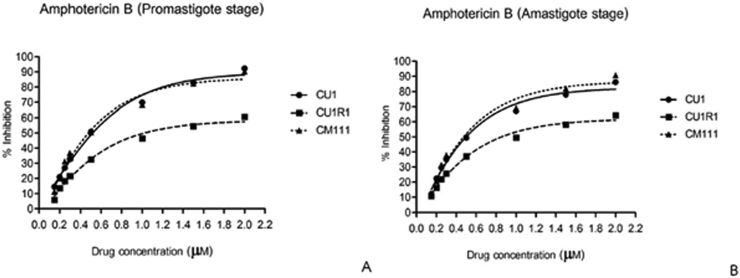
Comparative of % inhibition in promastigote (A) and amastigote (B) stages with amphotericin B. Experiments were performed in triplicate.